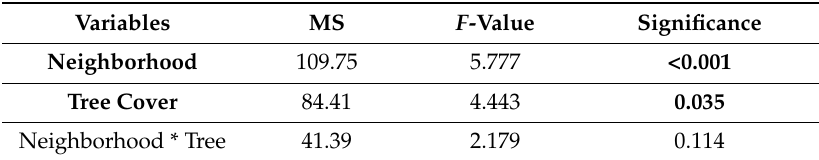
Table 9. Two-way ANOVA for top 10% of heat index values at 1500 LDT based on neighborhood classification and tree density, including mean-square error (MS), F value, and significance. Bold variables are significant ( p <